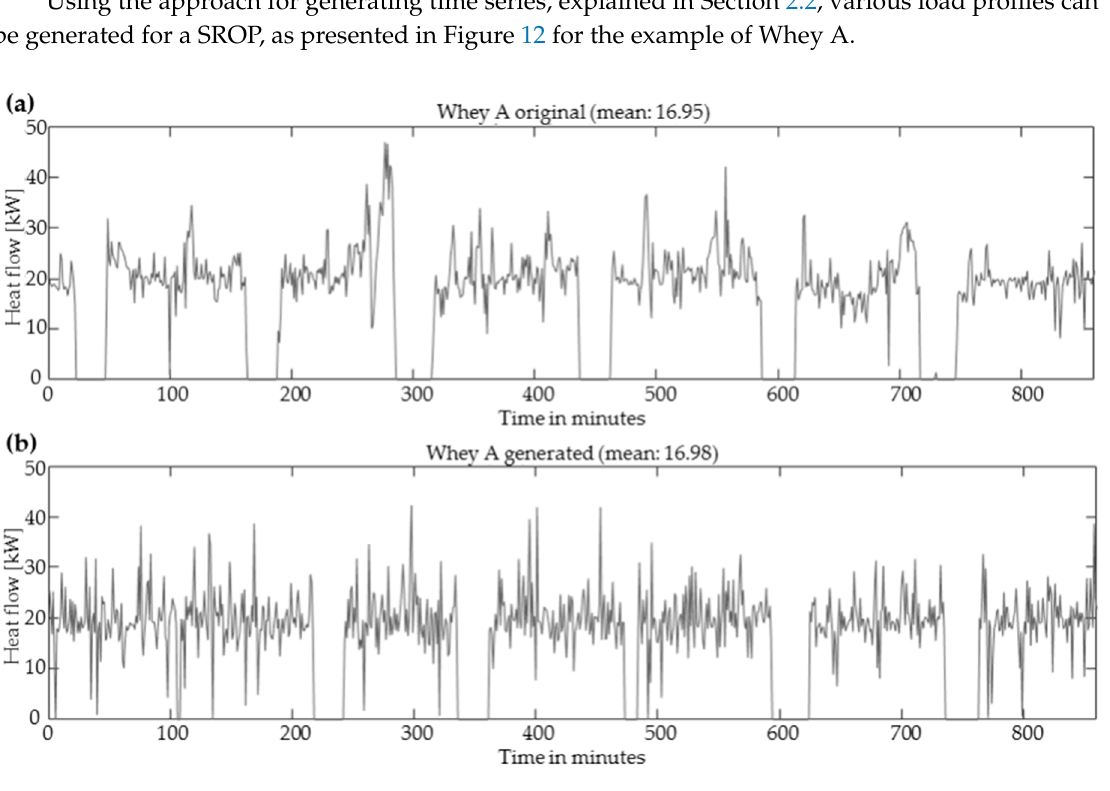
Figure 12. ( a ) Original time series of Whey A compared to the ( b ) generated one.